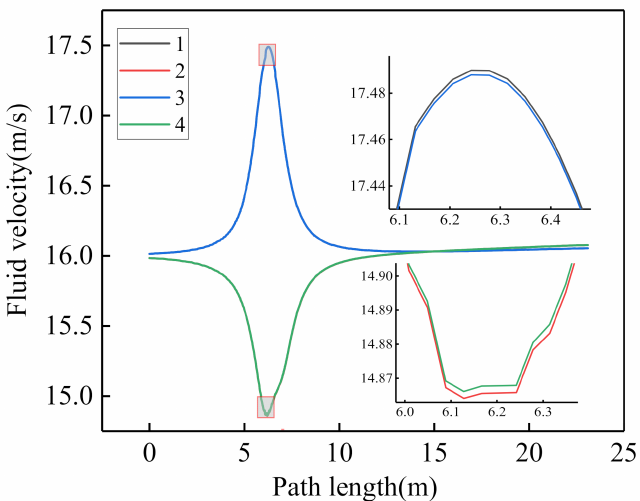
Figure 19. The velocities of fluid along the trajectories of Particle ID = 23,000 and Particle ID = 45,000 (1: Particle ID = 45,000 without particles; 2: Particle ID = 23,000 without particles; 3: Par- ticle ID = 45,000 (particle diameter = 2500 µ m); 4: Particle ID = 23,000 (particle diameter = 2500 µ m)).